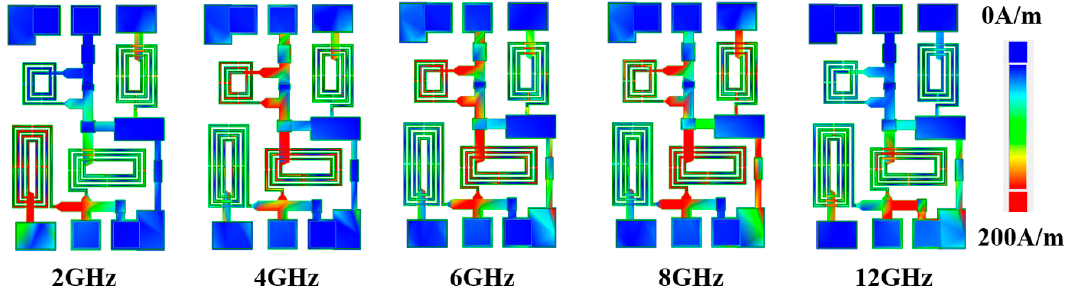
Figure 9. Current distribution of the proposed filter at different frequencies.